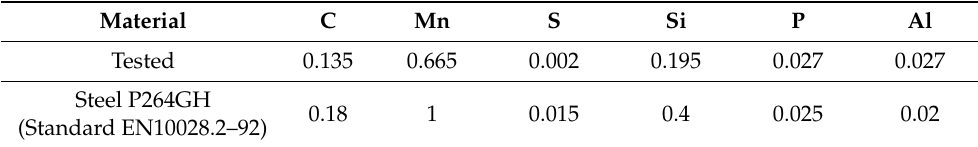
Table 3. Chemical composition of